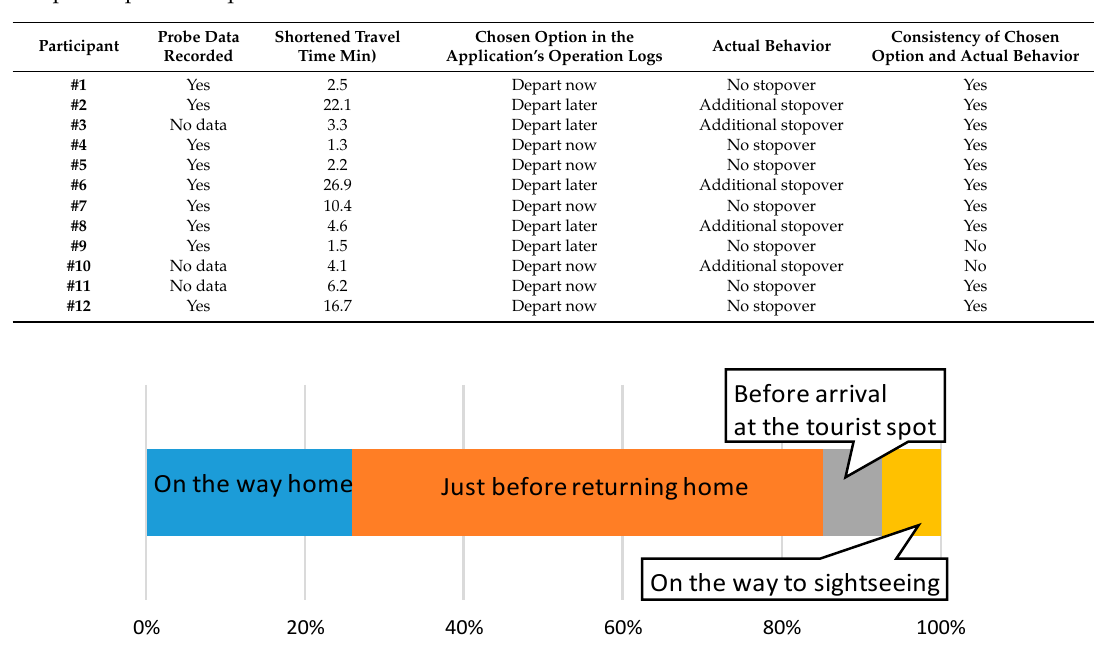
Figure 7. Timing of searches for returning routes using the app.